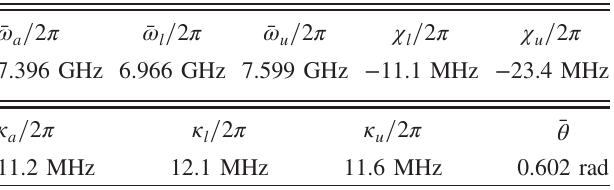
TABLE IV. Parameters at nonzero flux Φ ¼ 5 Φ 0 and T ¼ 20 mK. All the rest of the parameters do not strongly depend on flux and they are the same as in Tables II and III.